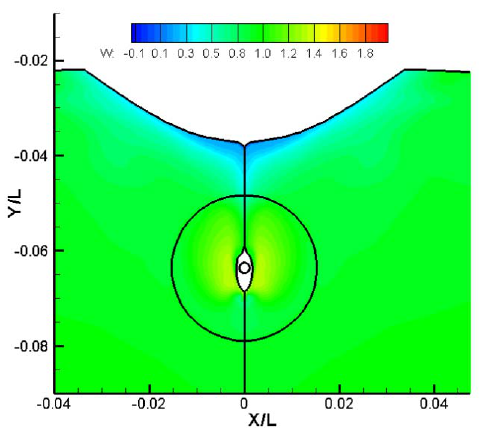
Figure 27. Axial velocity isowake curves on the propeller plane for a local minimum of the added resistance.